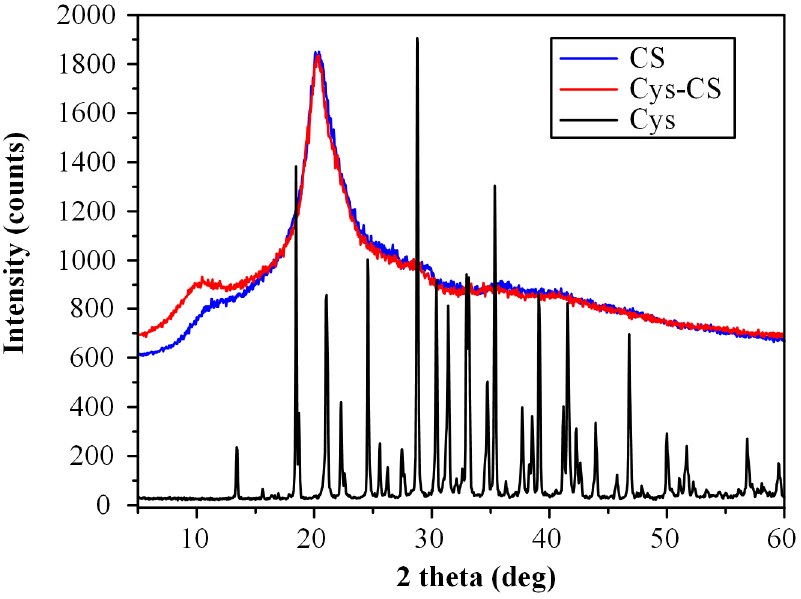
Figure 4. pXRD diffractograms of the neat CS, the neat Cys and the conjugated